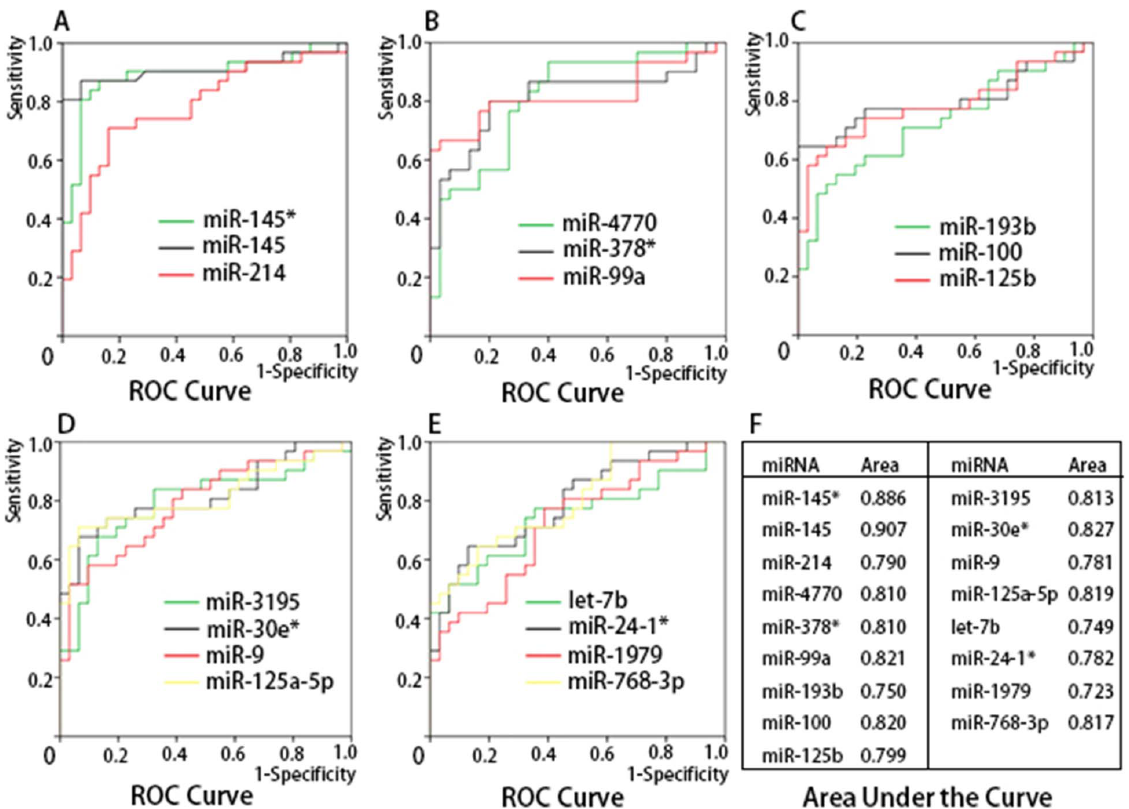
Figure 2. ROC curve analysis of 17 dysregulated miRNAs. Analysis of data implied that most of the dysregulated miRNAs have potential as diagnostic biomarkers for CRC detection, with high sensitivity and specificity.